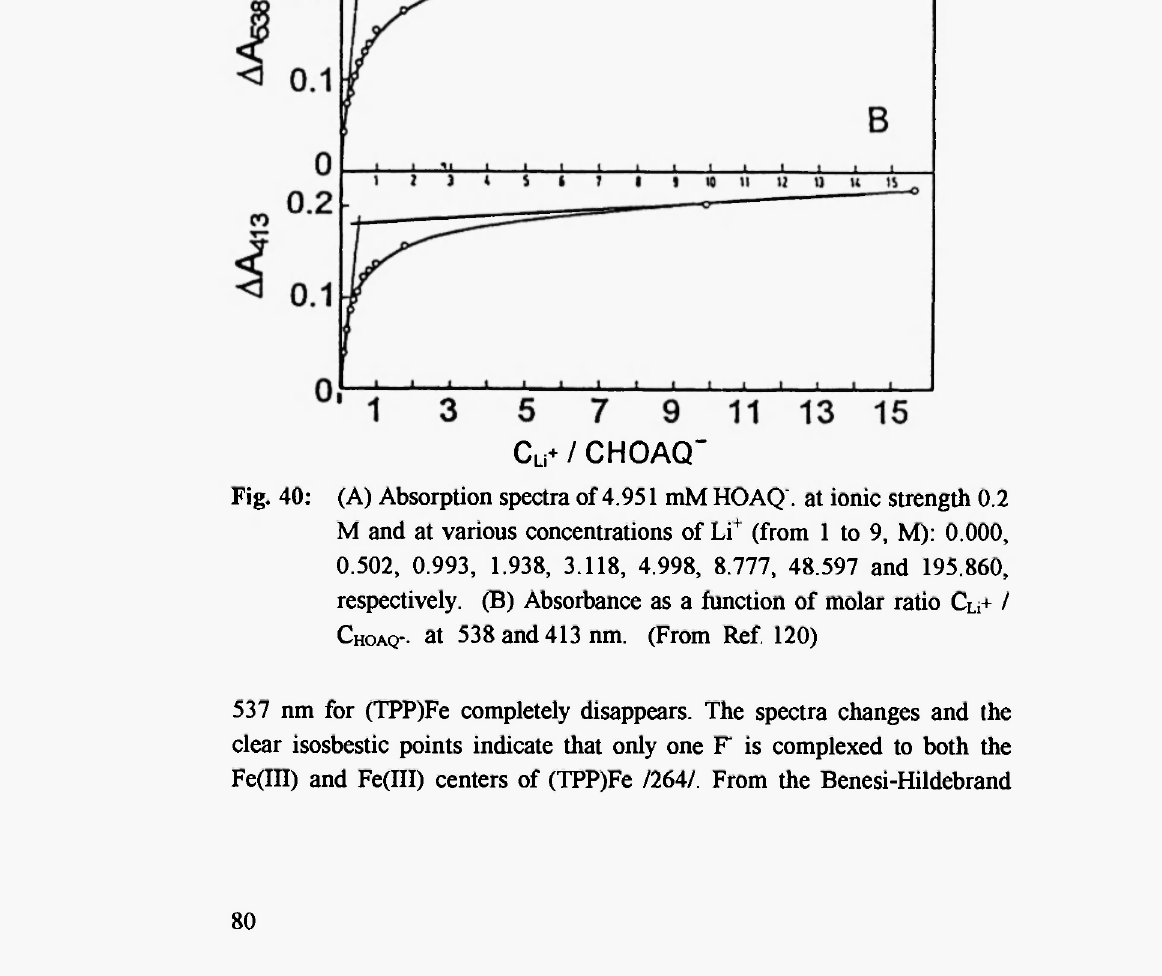
Fig. 40: (A) Absorption spectra of 4 .951 mM HOAQ". at ionic strength 0.2 Μ and at various concentrations of Li + (from 1 to 9, M): 0.000, 0.502, 0.993, 1.938, 3.118, 4.998, 8.777, 48.597 and 195.860, respectively. (B) Absorbance as a function of molar ratio C CHOAQ -· at 538 and 413 nm. (From Ref. 120) 537 nm for (TPP)Fe completely disappears. The spectra changes and the clear isosbestic points indicate that only one F is complexed to both the Fe(III) and Fe(III) centers of (TPP)Fe /264/. From the Benesi-Hildebrand